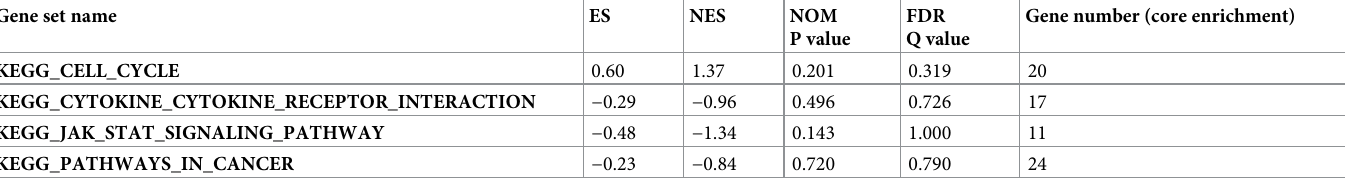
Table 1. Gene sets (pathways) that were strongly related to breast